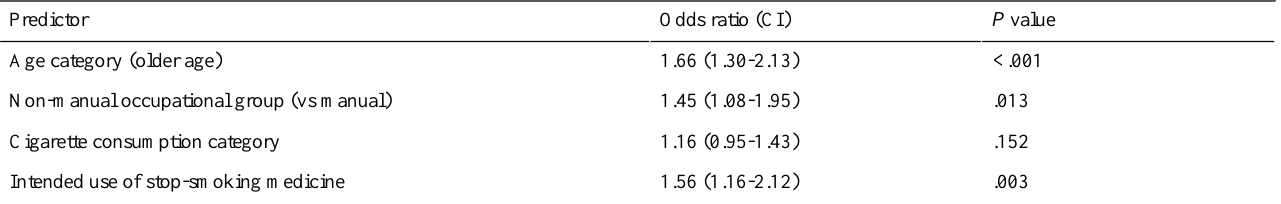
Table 1. Associations between smoker characteristics and recorded abstinence (all odds ratios are unadjusted).